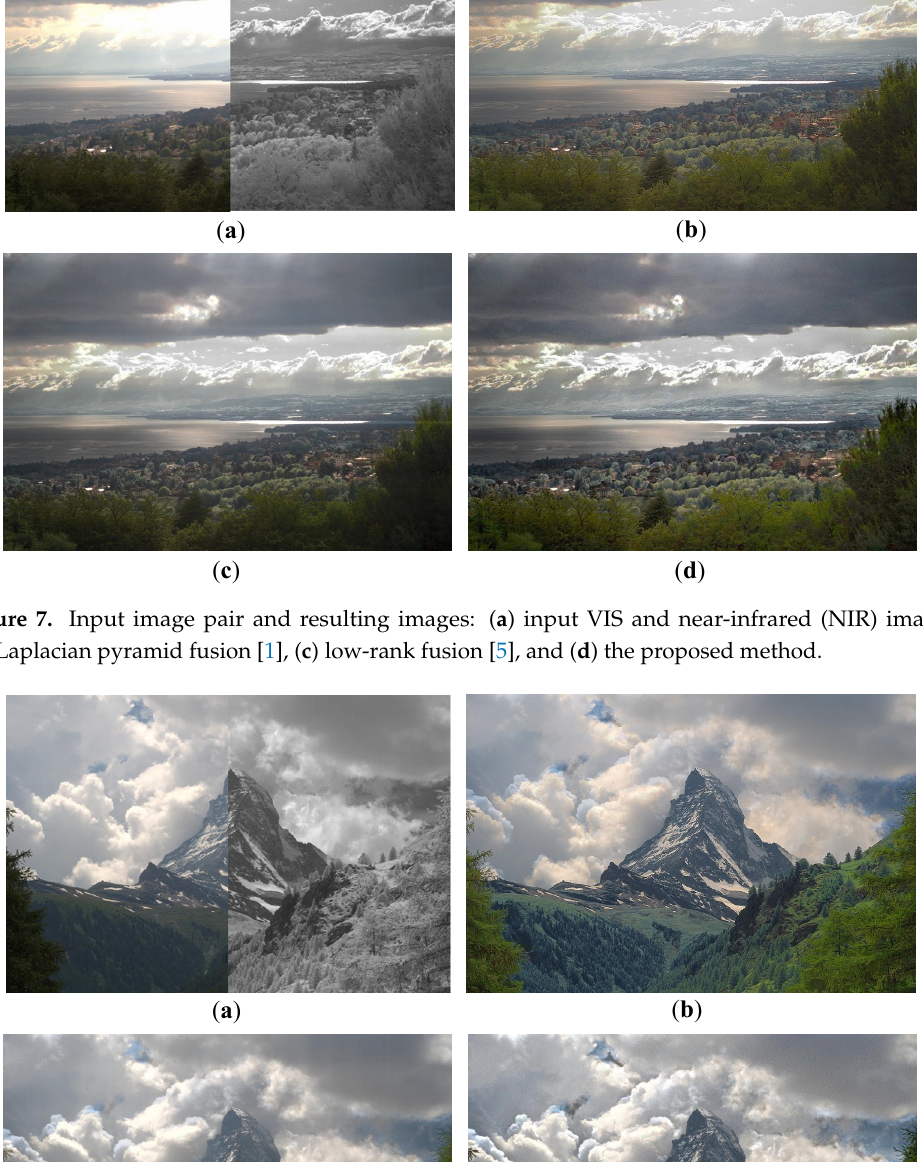
fusion [1], (c) low-rank fusion [5], and (d) the proposed method.